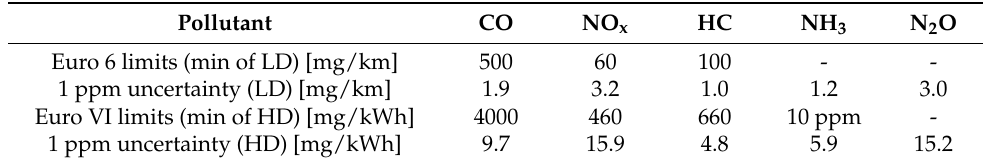
Table 2. Current Euro 6/VI limits in the laboratory (min from compression ignition and positive ignition engines) for light-duty (LD) vehicles and heavy-duty (HD) engines. The uncertainty